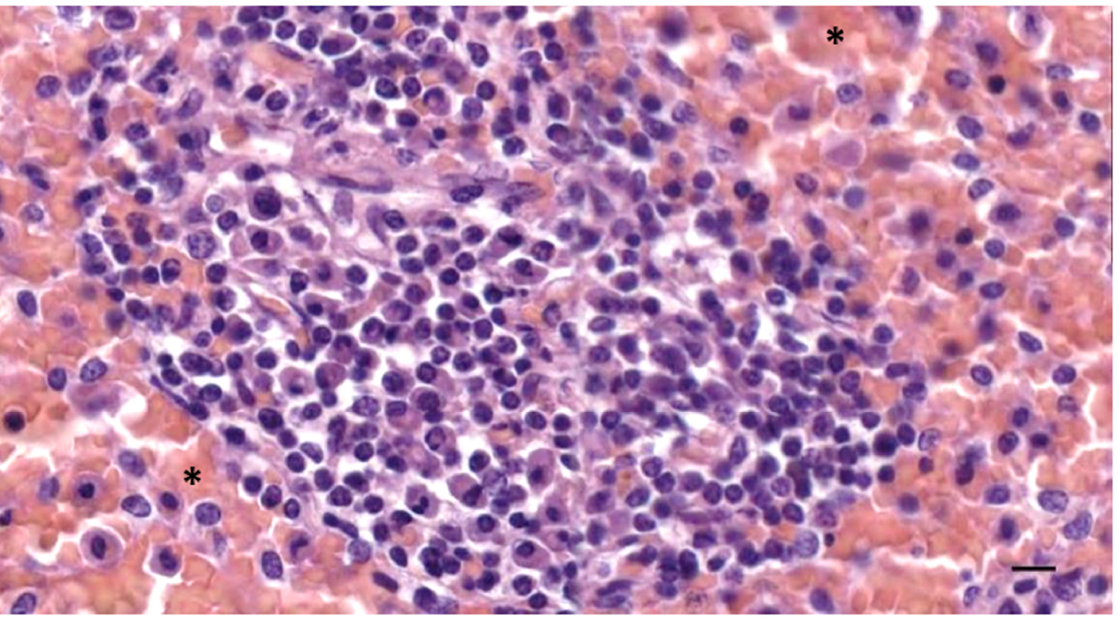
Figure 11. A histological image (274/18_8R) of the immunohistochemical analysis of a lymphoid follicle stained with ( A ) anti-CD3, ( B ) anti-CD20, ( C ) anti-HLA-DR, ( D ) anti-Iba1, ( E ) anti-vimentin ( E ). Scale = 100 µm.